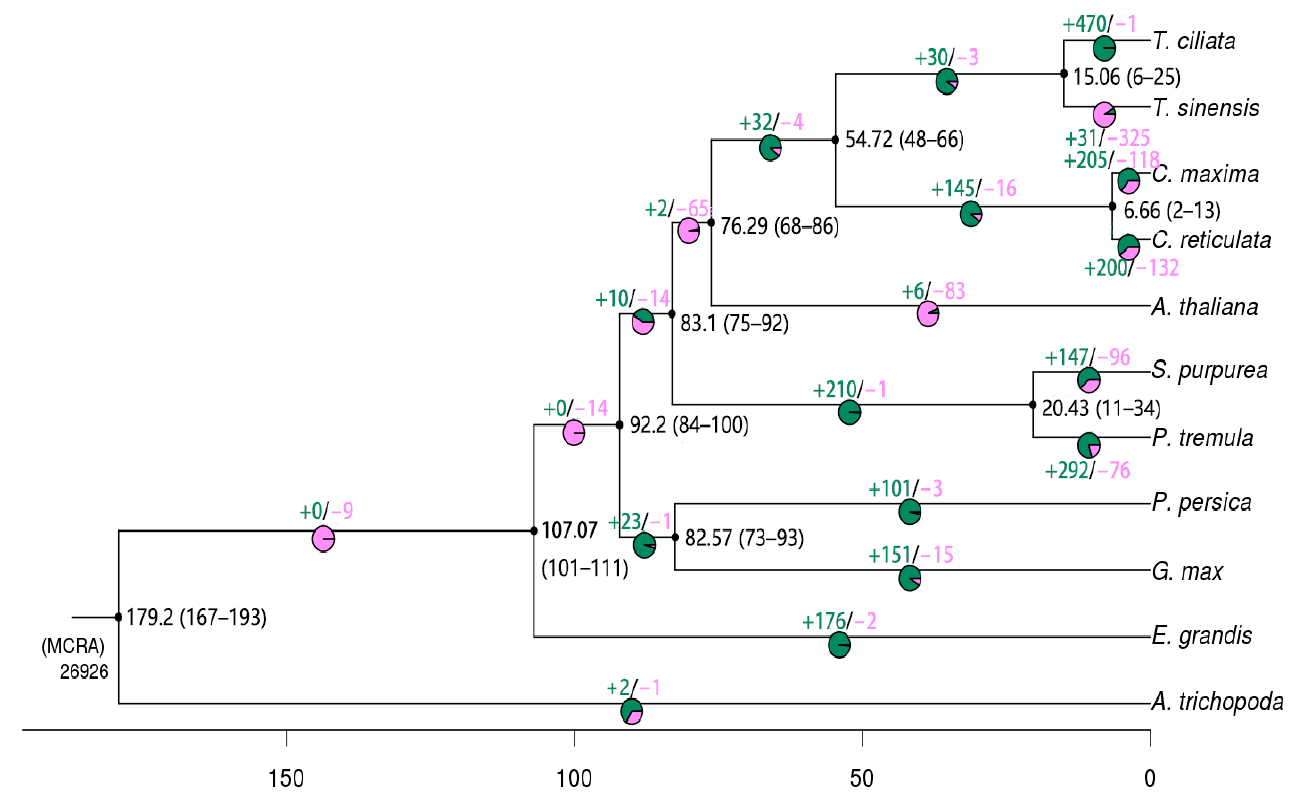
Figure 2. Expansion and contraction of gene families in eleven species. Pie chart sectors on each branch represent expansion of gene families in green and contraction of gene families in red. The values at each branch node are divergent times in Mya, with 95% confidence intervals in parenthe- ses.